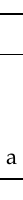
Table 3. Dualex indexes of nitrogen balance index (NBI), total chlorophylls (Chl), flavonols (Flav) and anthocyanins (Anth) measured in the fresh leaves of pepper plants fertigated with nutrient solutions made with conventional fertilization (CF), MCT ® fertilizers (HF) and MCT ® fertilizers plus TX (HFX). Data are represented as the mean ± standard deviation. Different letters indicate significant differences between treatments ( p < 0.05, n = 4).